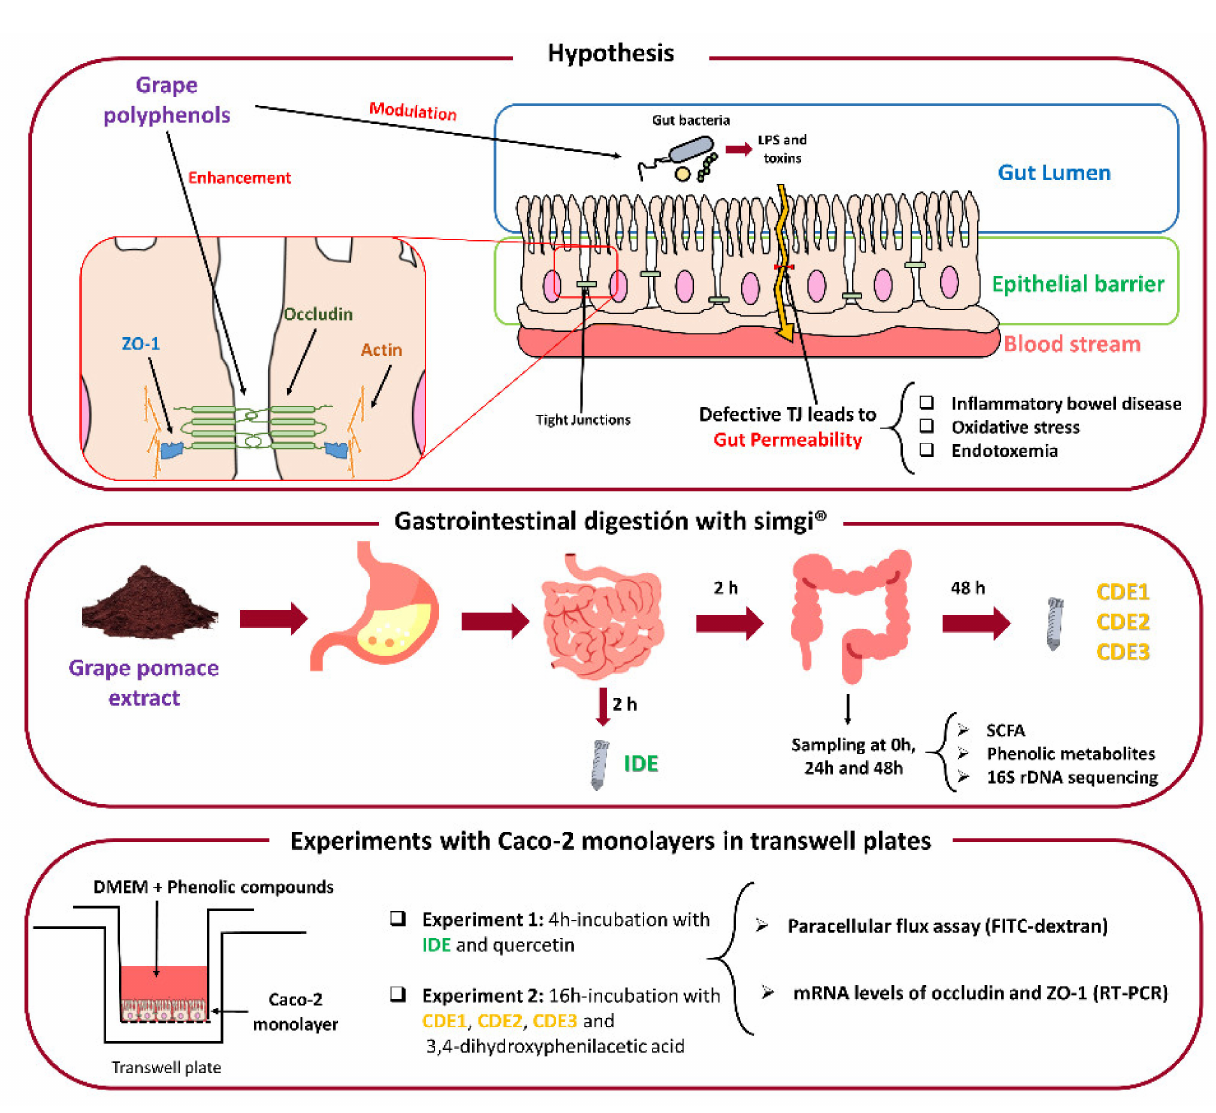
Figure 1. The main objectives of the present study and the experimental design. TJ: Tight junctions. IDE: Intestinal-digested extract. CDE: Colonic-digested extract. SCFA: Short-chain fatty acids. DMEM: Glucose Dulbecco’s modified Eagle’s medium. FITC: Fluorescein